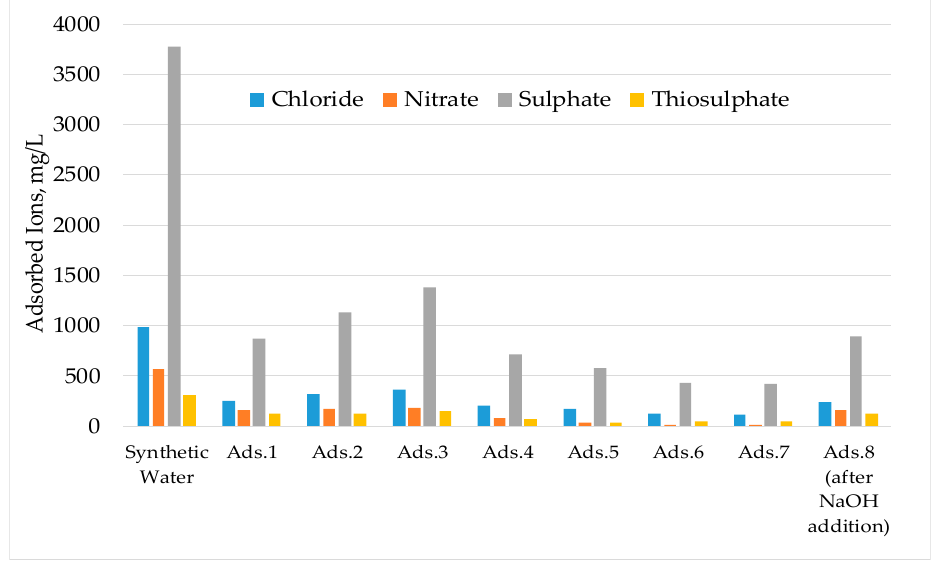
Figure 8. Adsorption capacity of the regenerated resin.